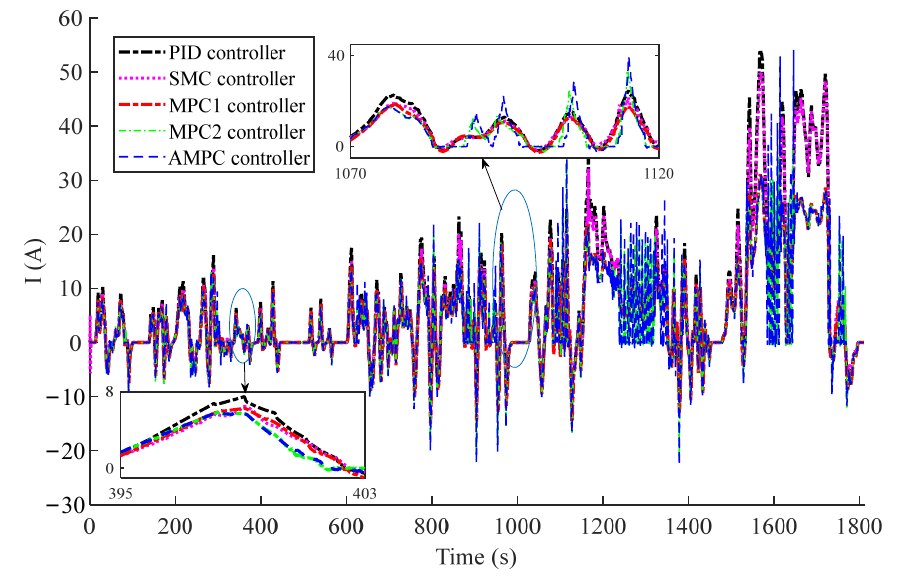
Figure 12. Current curve of each controller.